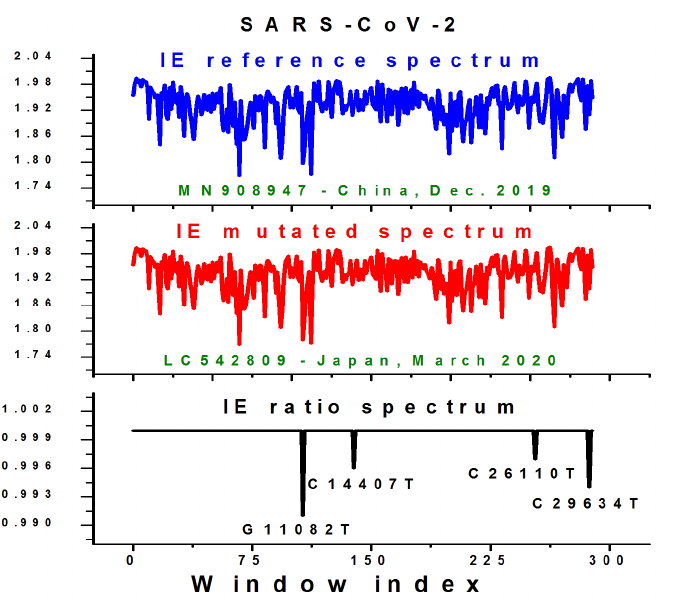
Figure 4. The IE spectra of the reference SARS-CoV-2 genome ( top image), the mutated sequence ( middle image), and their IE ratio (IER) spectrum ( bottom image) obtained by dividing the two IE spectra. The four known mutations are captured in the IER spectrum and clearly marked. The IE of the corresponding window decreased in each case. Data obtained for WS = SS = 103.